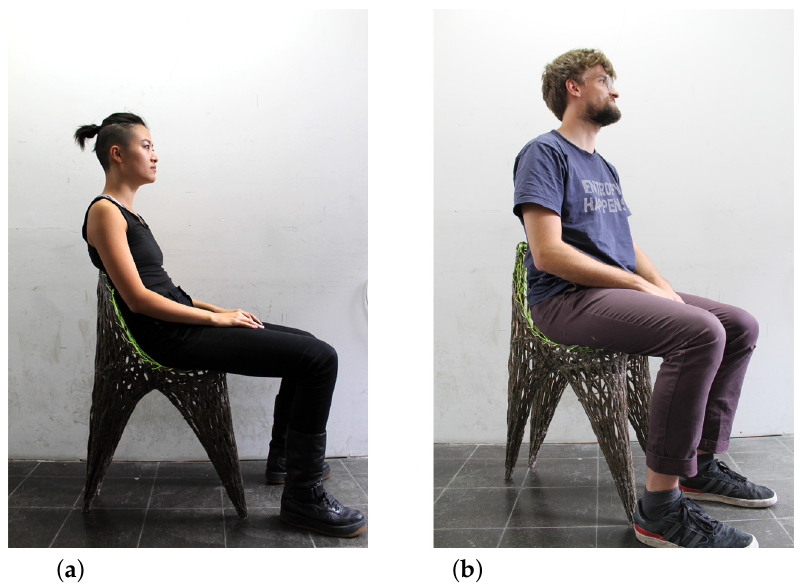
Figure 19. Proof of concept: chair can hold an adult with minimal deflection. ( a ) 56 kg user ( b ) 85 kg